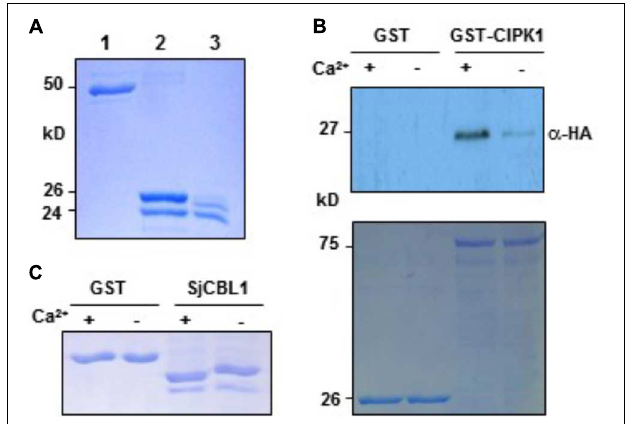
FIGURE 7 | In vitro interaction between SjCBL1 and CIPK1 in a Ca 2 + -dependent manner. (A) Purification of the recombinant SjCBL1 protein expressed in Escherichia coli. Lanes 1–3 contain the GST-SjCBL1 form, the thrombin digested forms of GST and SjCBL1, and purified SjCBL1, respectively. (B) Gel shift assay showing Ca 2 + -binding affinity of the recombinant SjCBL1 protein. The indicated proteins were incubated in 2 mM EGTA (–) or 1 mM CaCl 2 (+) before being analyzed with SDS-PAGE. (C) Pull-down assay. The GST-CIPK1 fusion protein was used as a bait to pull down the prey SjCBL10:HA in the presence (+, 1 mM CaCl 2 ) or absence (–, 2 mM EGTA) of calcium. For a negative control, GST alone was used as a bait. The top panel shows a western blot probed with rabbit anti-HA antibody and the bottom panel shows a Coomassie Brillant Blue stained SDS-PAGE gel indicating the amount of bait proteins used in each pull-down assay.